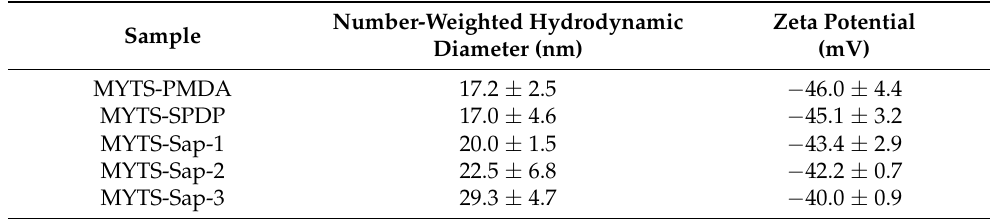
Figure 1. ( A ) TEM image of iron oxide cores. Scale bar: 50 nm; size distribution ( n = 100). ( B ) Size distribution of MYTS-PMDA evaluated by DLS. ( C ) Schematic representation of MYTS-Sap synthesis reactions. Table 1. Summary of DLS and zeta potential characterization of nanoparticles throughout the synthesis process. Data are expressed as the means of three measurements ± SDs.